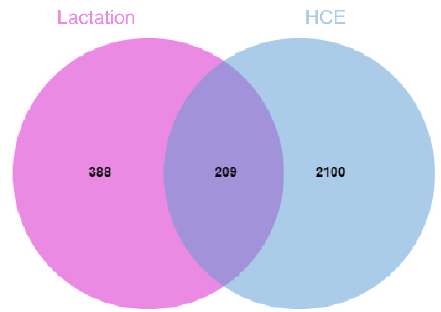
Figure 2. Venn diagram of lactation and daylily.